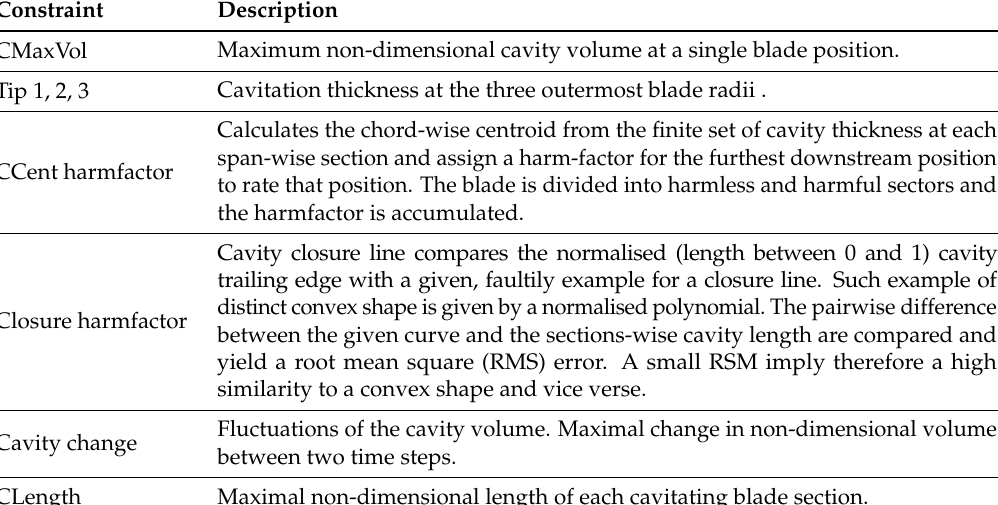
Table 1. Cavity shape constraints.